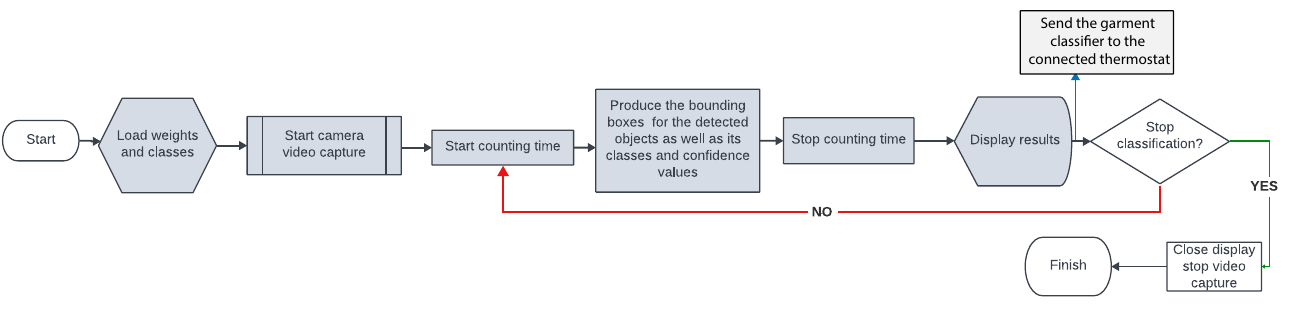
Figure 7. Real Time clothing classifier flow